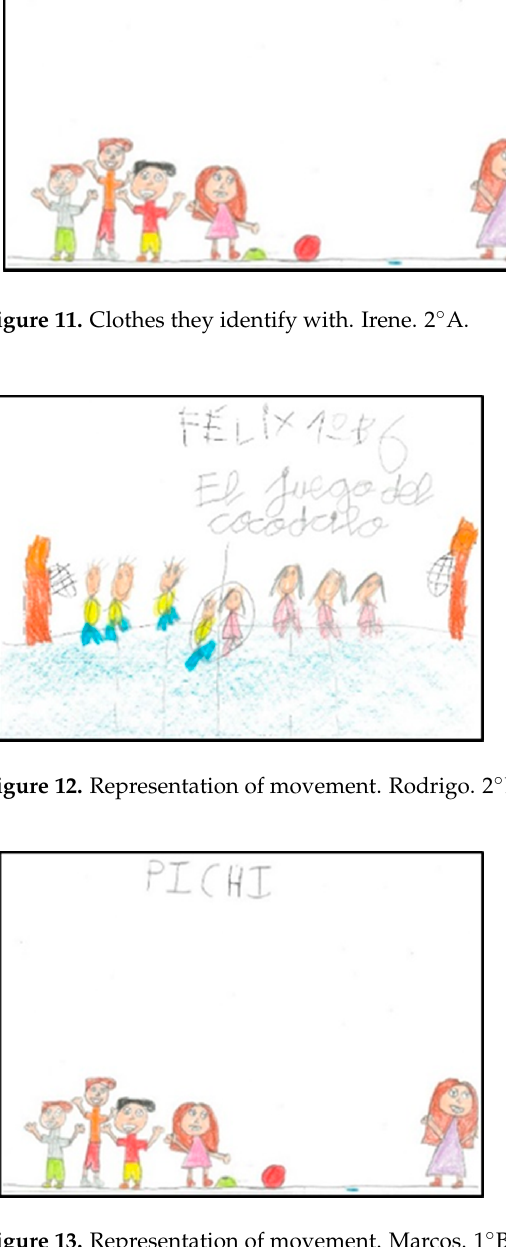
Figure 13. Representation of movement. Marcos. 1°B. Some drawings (N = 5) represent the people with respect to the original position they would occupy at the real moment of the game played. It can be seen in the following drawing how the persons occupying the goalkeeper’s position are drawn in a different position to the rest, even specifying that the goalkeeper on the right has thrown herself to the ground to stop the ball (Figure